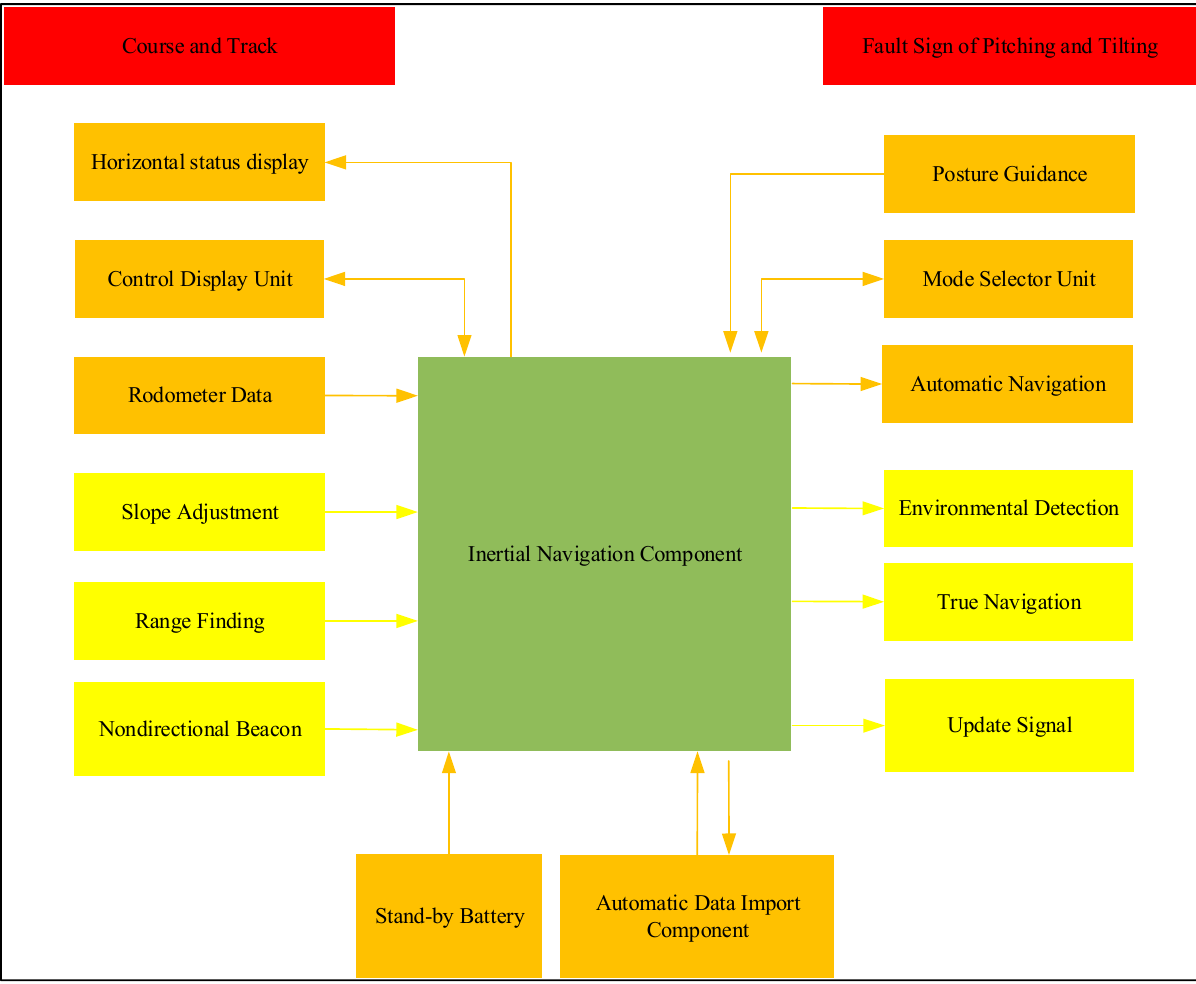
Figure 3. Structure diagram of the Inertial Navigation Straight Finding System.